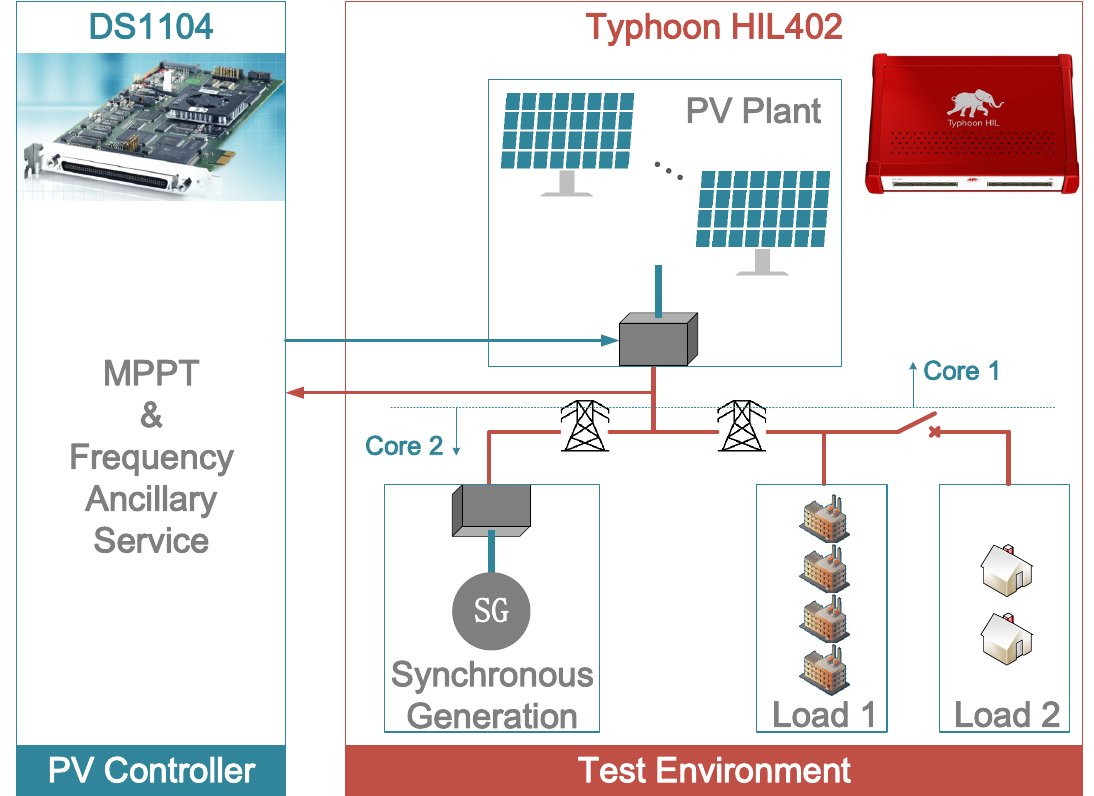
Figure 4. Simulation Framework: Controller-hardware-in-the-loop (C-Hil) is performed with dSPACE DS1404 and the real-time simulator is the Typhoon